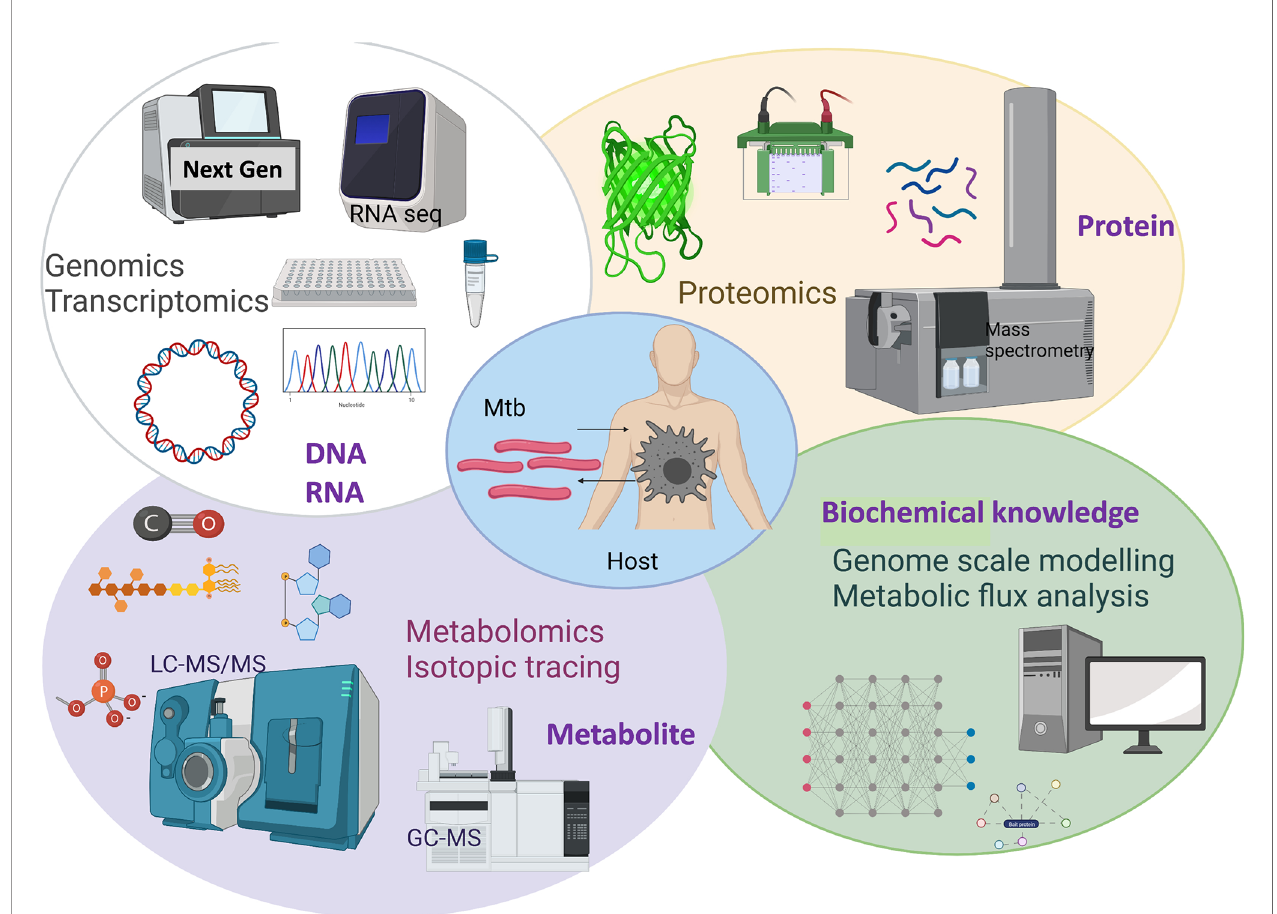
FIGURE 1 | Overview of systems-based omics used for exploring Mtb and host metabolic interactions. Created with